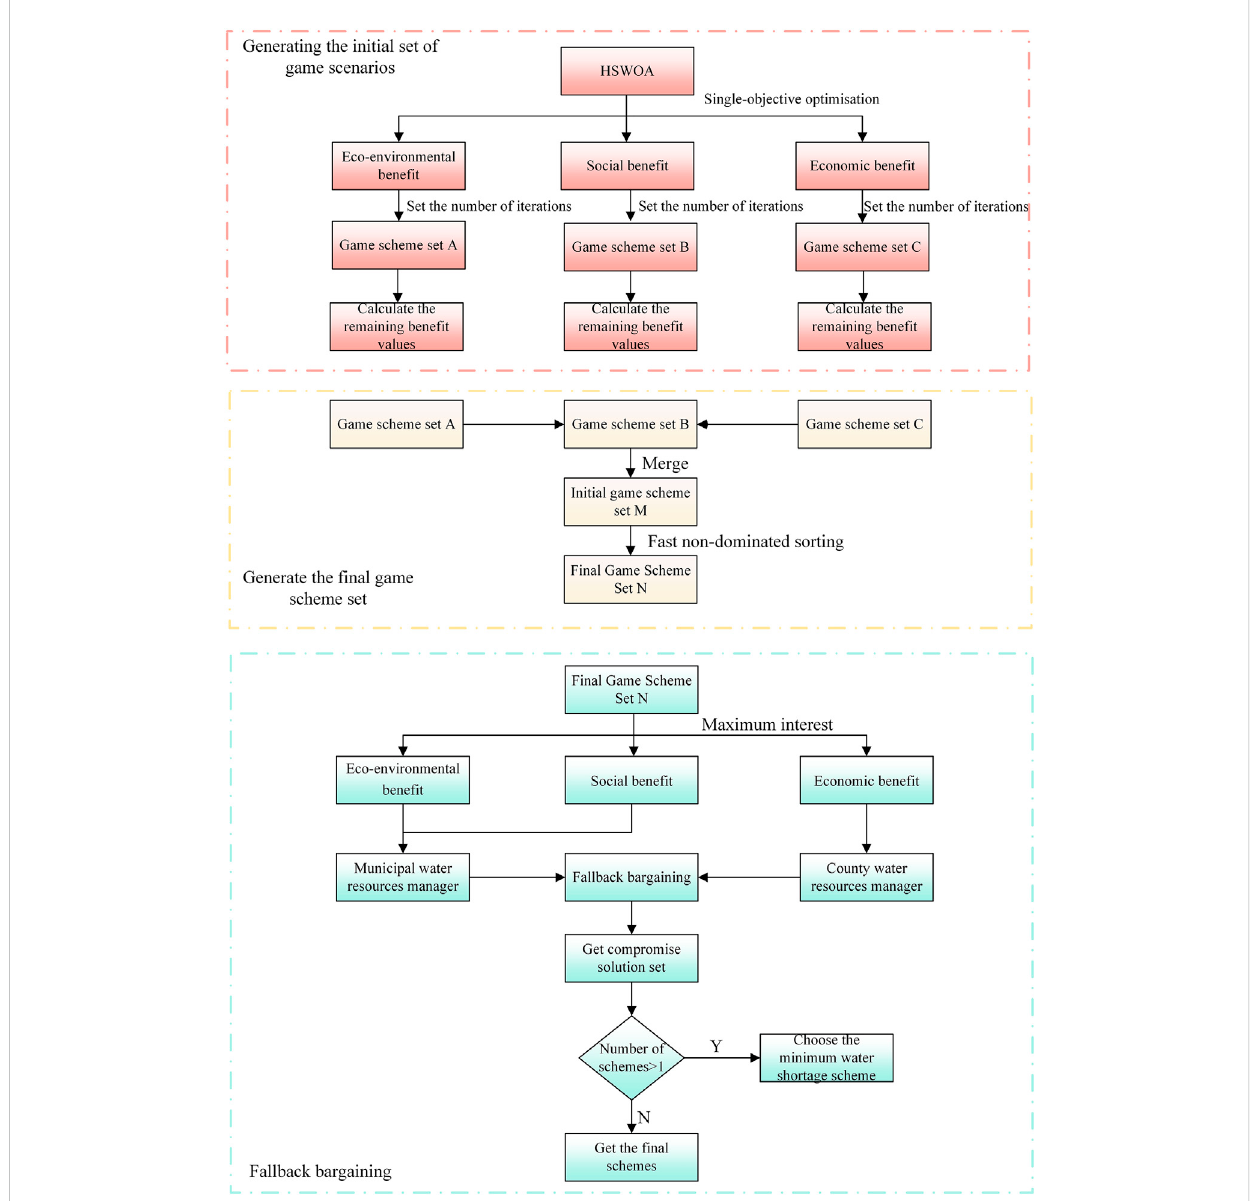
FIGURE 1 Flowchart of a water resource optimization model at the city and county